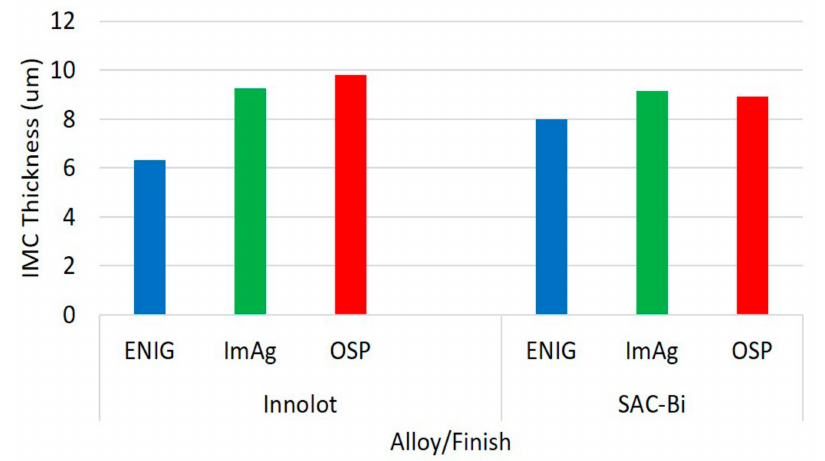
Figure 8. IMC layer thickness measurements.